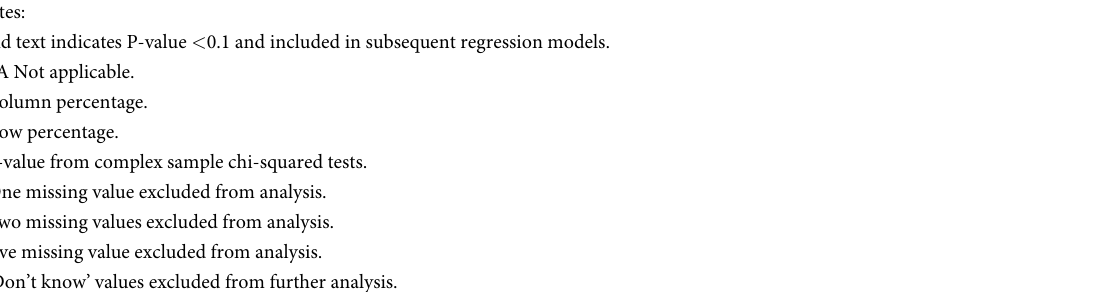
breastfeeding within two days post-delivery by a healthcare provider (p < 0.001), ethnicity (p = 0.001), ecological zone (p = 0.031) and province (p < 0.001). Since counselling regarding breastfeeding within two days of delivery and observation of breastfeeding within two days of delivery were highly associated with each other (p < 0.0005), only one of these variables, obser- vation of breastfeeding within two days of delivery, was included in the multivariable model. After adjustment, infants put on their mother’s bare skin immediately after birth had 2.10 times the odds of being breastfed within one hour of delivery compared with those who